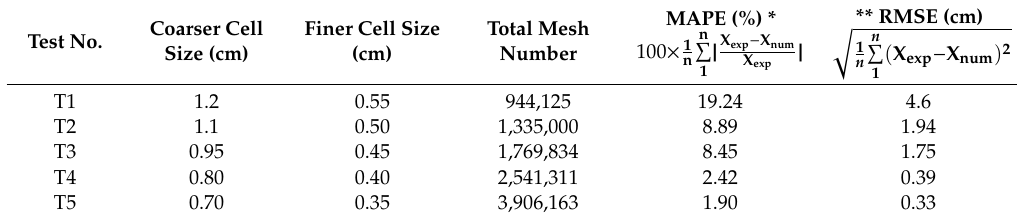
Table 2. Mesh-sensitivity analysis for present